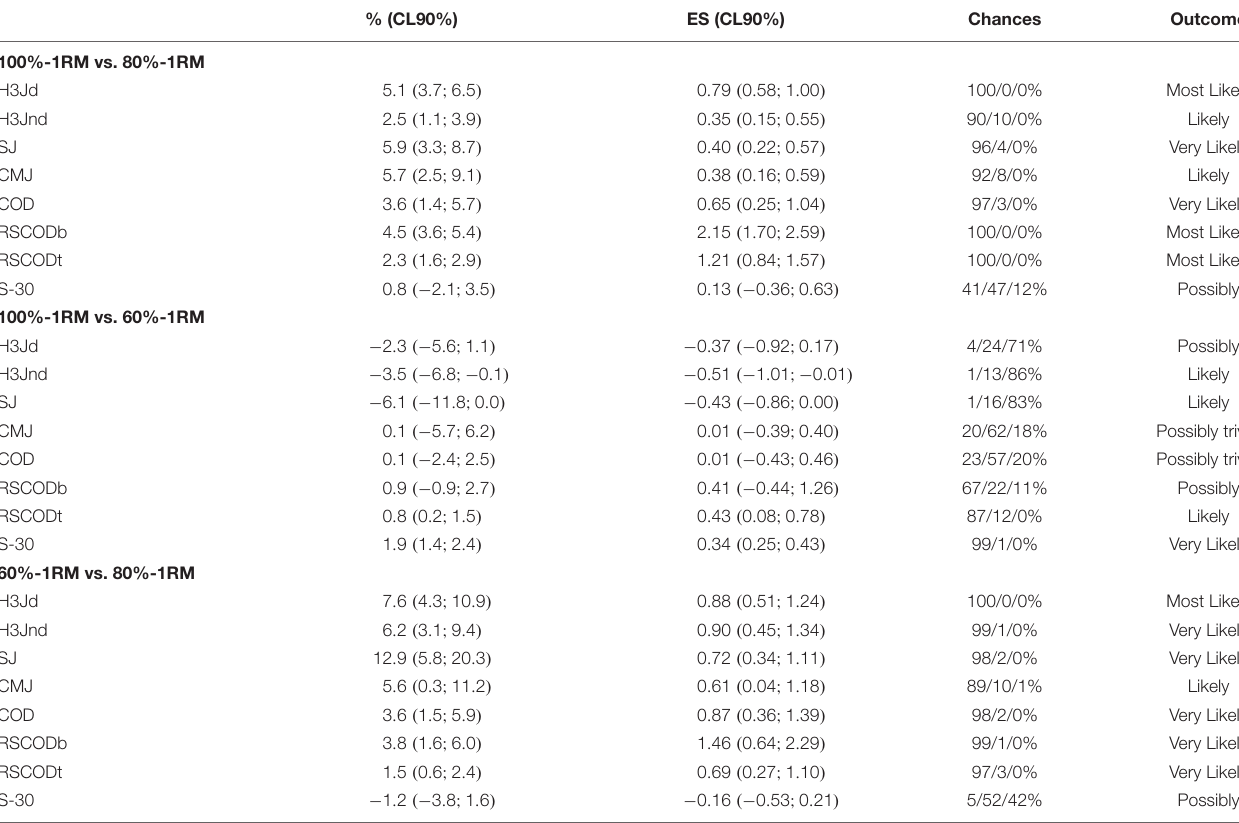
TABLE 3 | Comparisons of soccer player’s physical performance after three different warm-up conditions. % (CL90%) ES (CL90%) Chances